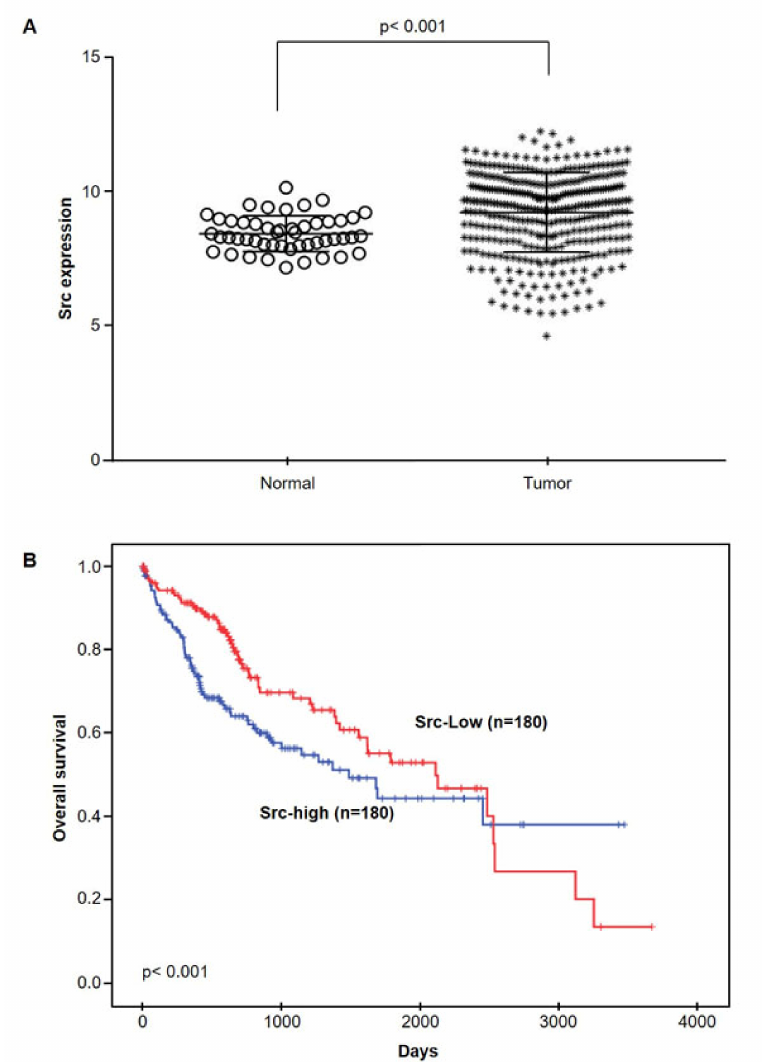
Figure 6. The correlation between Src overexpression and prognosis in hepatocellular carcinoma (HCC) patients. ( A ) The expression level of Src in HCC tissues (from the TCGA data analysis). ( B ) The overall survival rates for the Src high- and low-expression groups were obtained from the